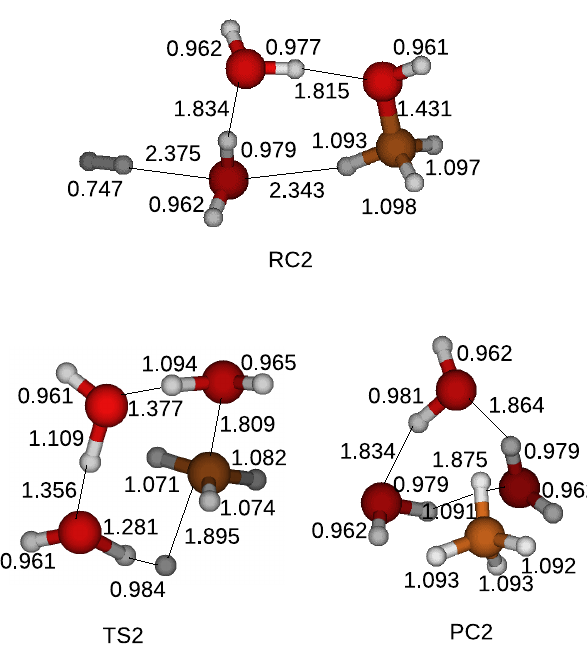
Figure 4. Calculated geometries of a reactant compound (RC2), a transition state (TS2), and a product compound (PC2) for the reduction of a methanol when two water molecules are involved in the